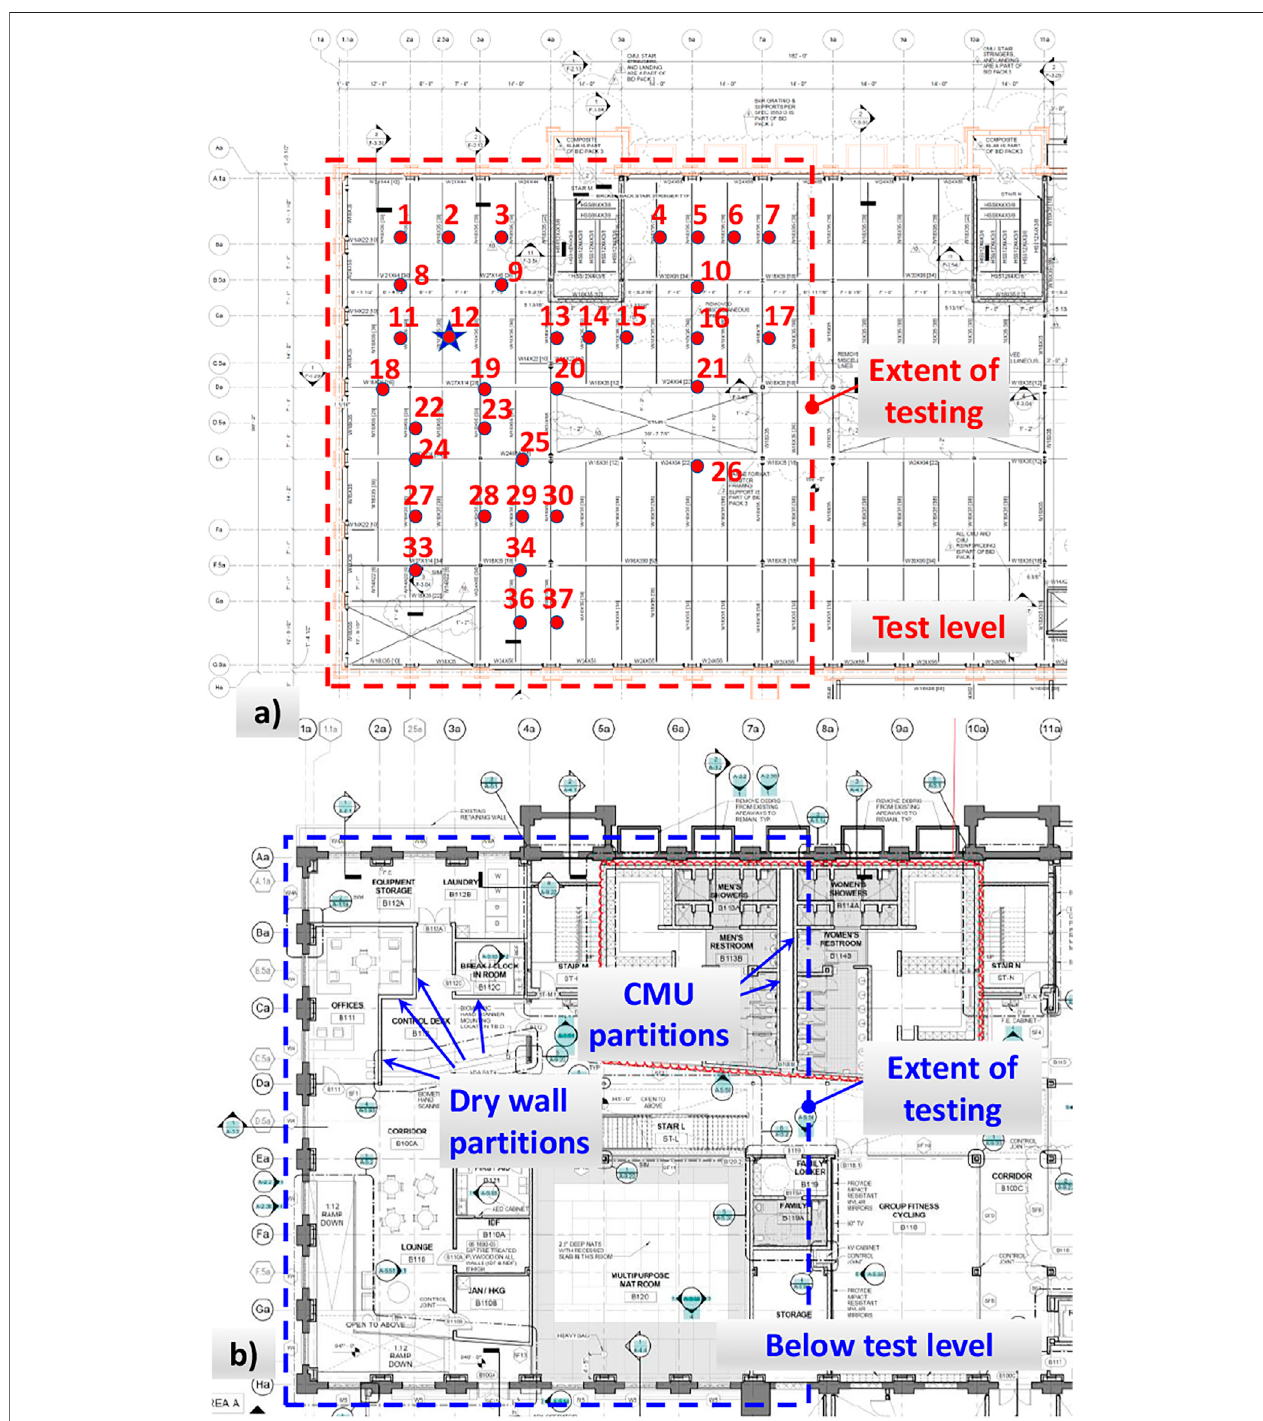
FIGURE 2 | Extent of testing on the (A) test level and (B) below test level.